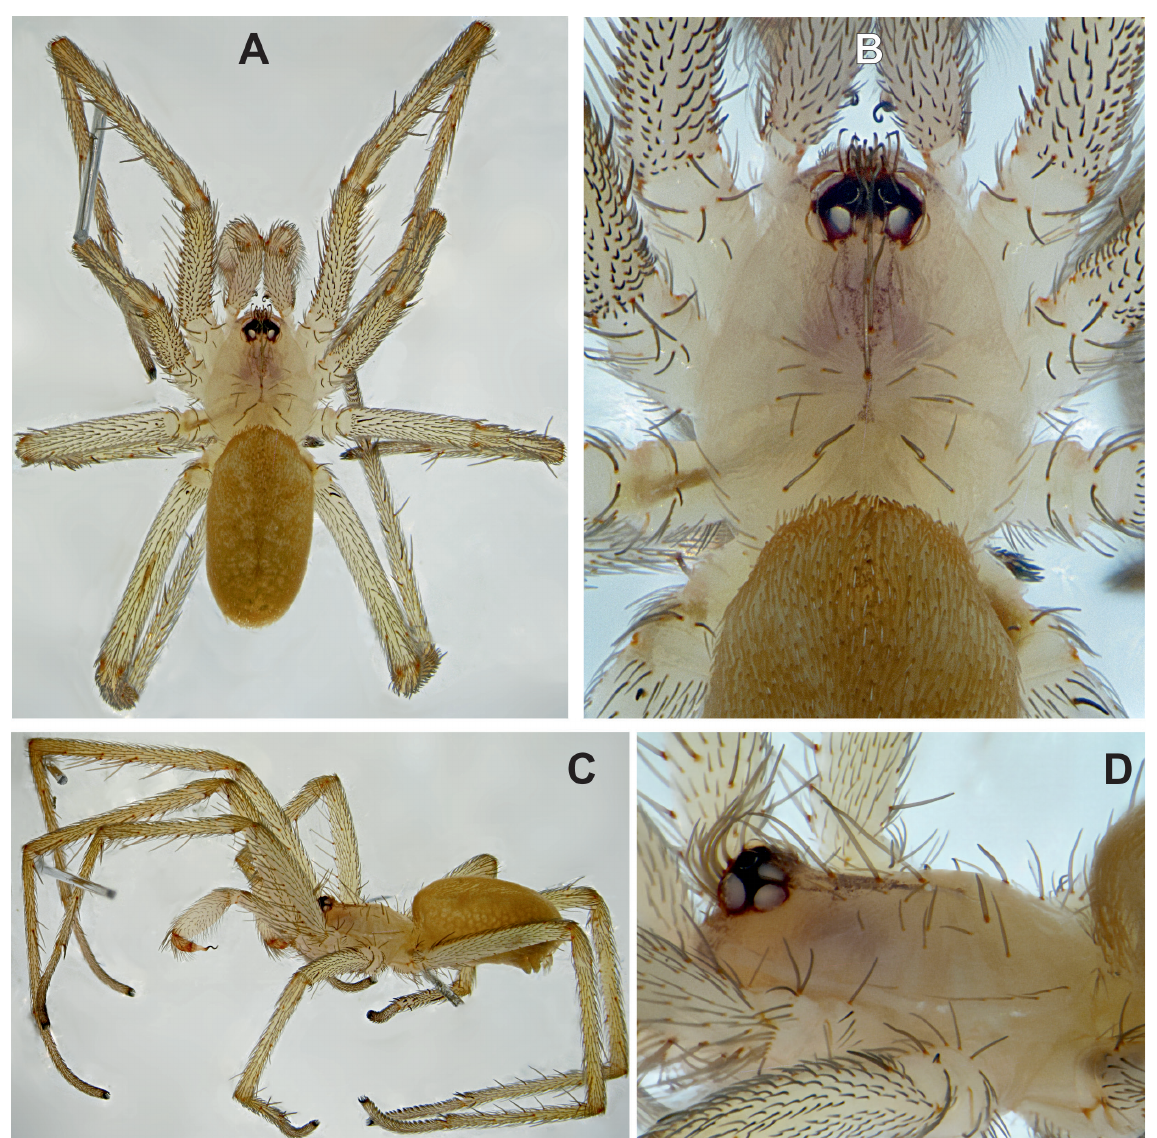
Fig. 24. Somatic characters of Zaitunia martynovae (Andreeva & Tyshchenko, 1969), ♂ from Gandzhina. A , C . Habitus, dorsal and lateral. B , D . Prosoma, dorsal and